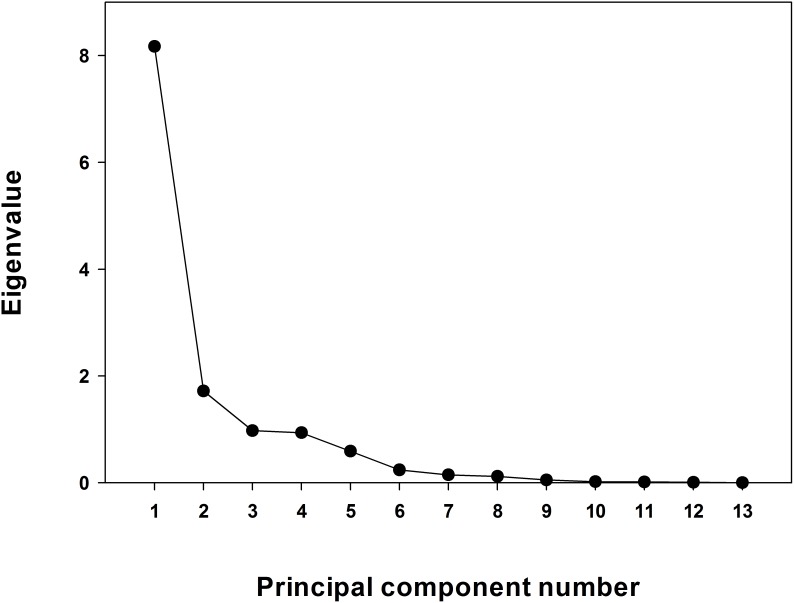
Scree plot of principal component analyses.